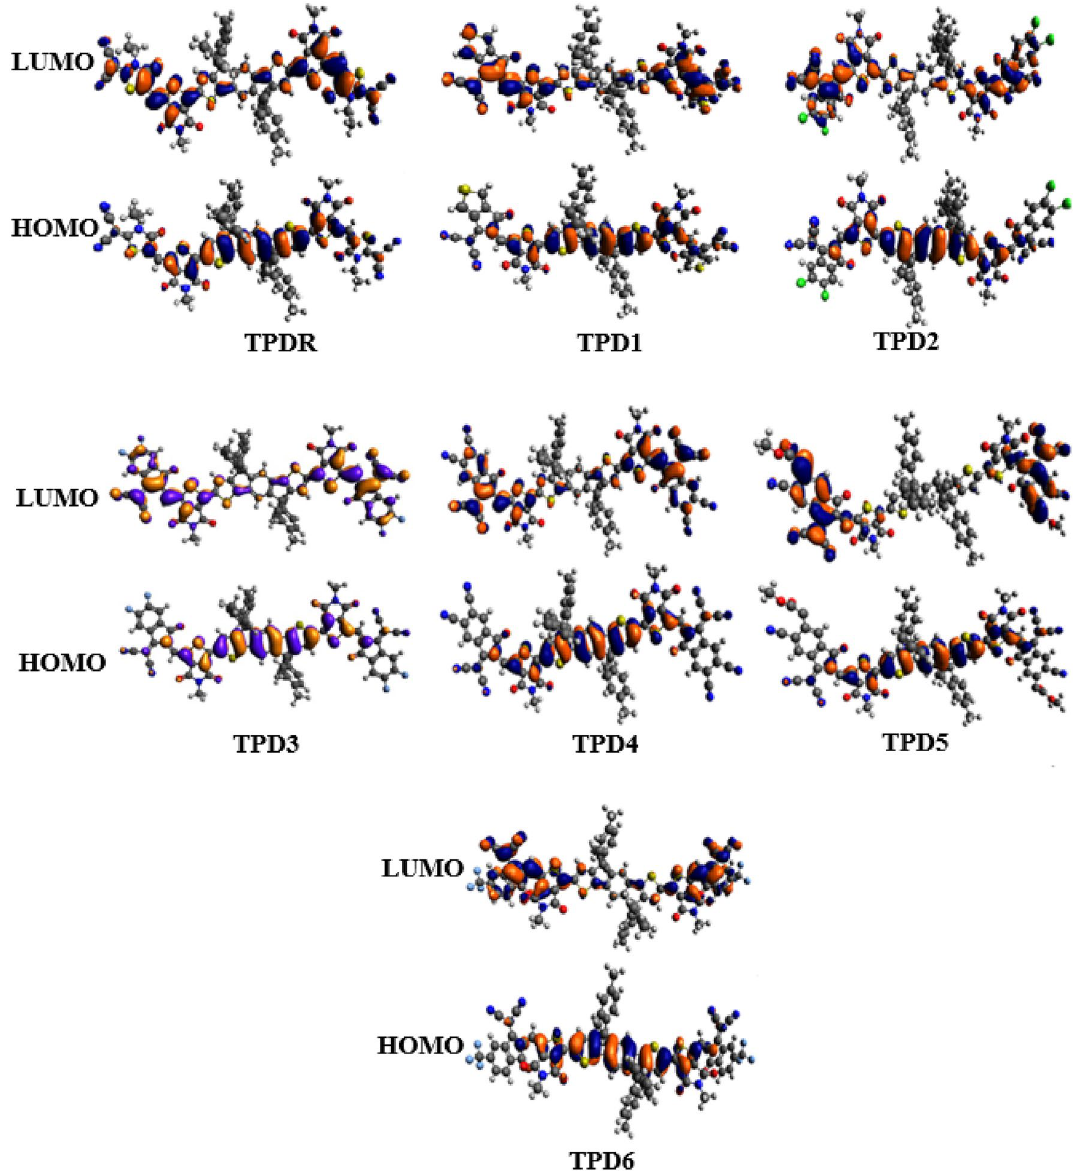
Figure 4. HOMOs and LUMOs of TPDR and TPD1 – TPD6